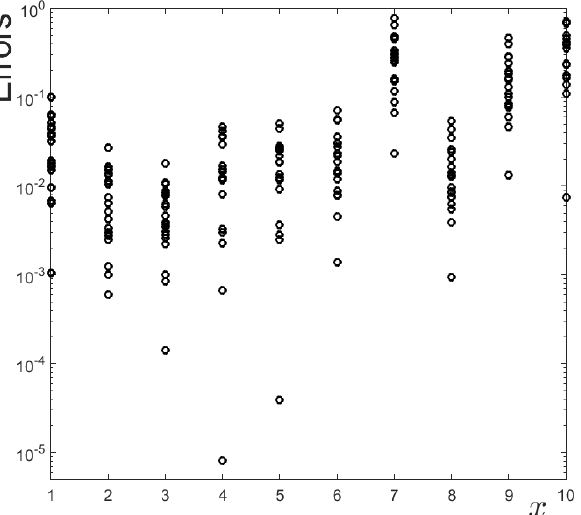
Figure 5. Errors of the computed degradations, Error x , as obtained by repeating the computations displayed in Table 3 twenty times, with randomly chosen exact degradations and initial conditions for the SQP